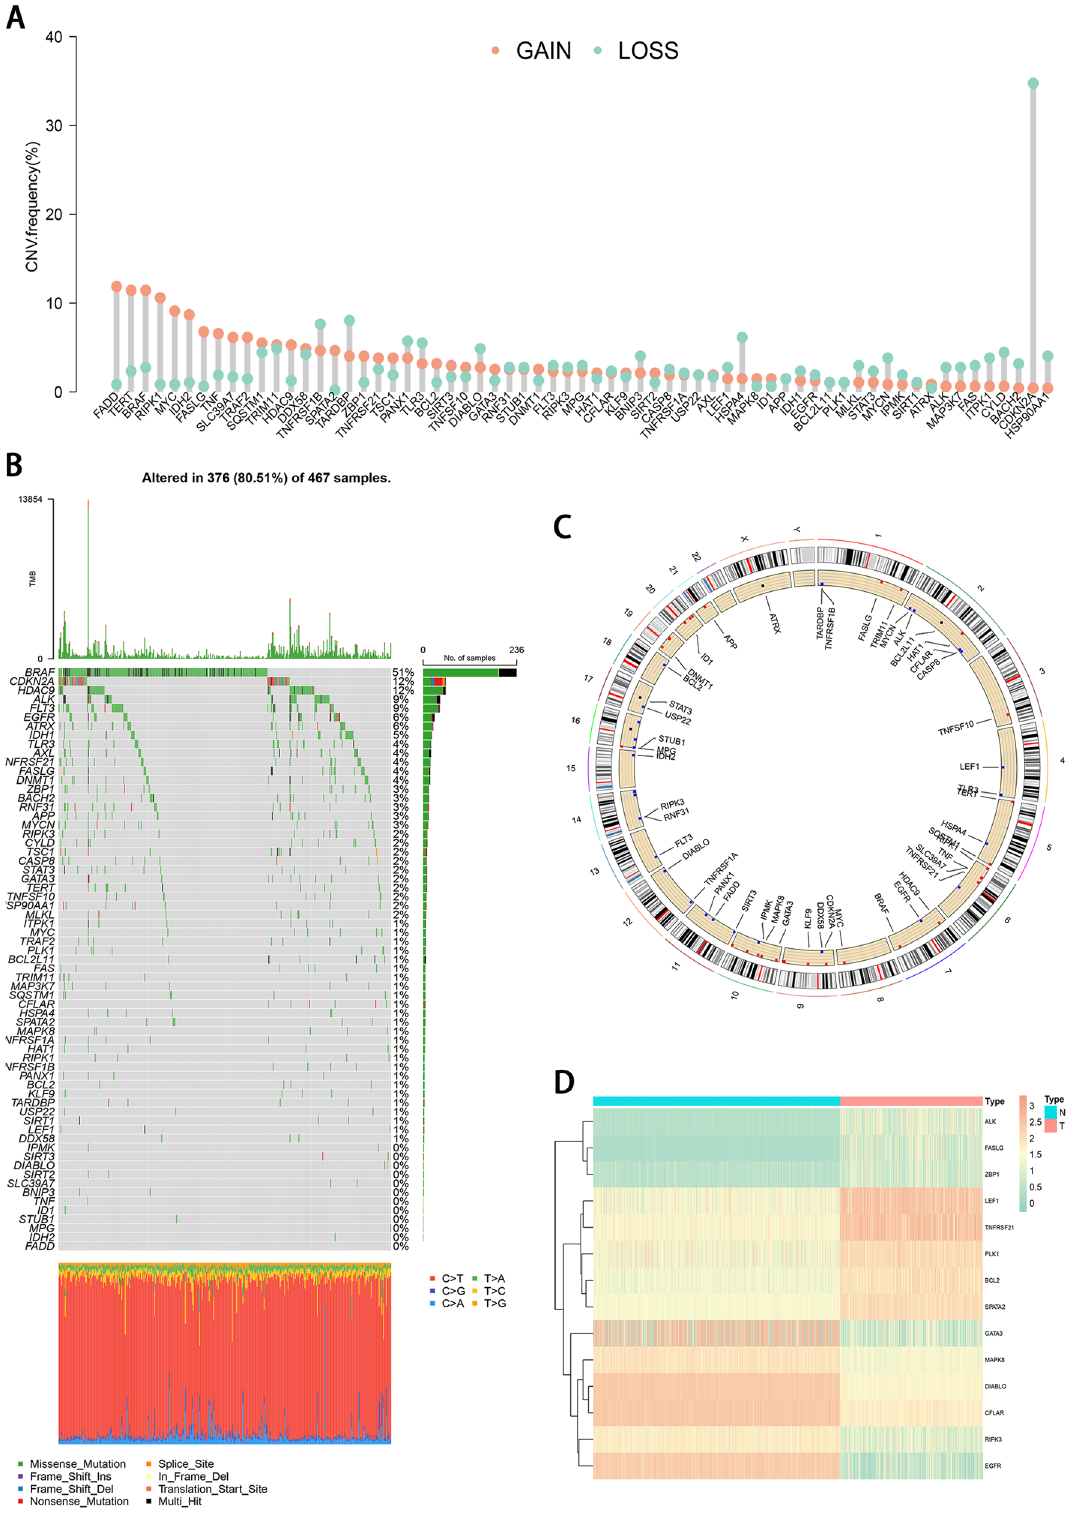
Figure 1. Landscape of genetic variation of 65 necroptosis-related genes in melanoma. ( A ) The CNV frequency of 65 necroptosis-related genes. ( B ) The somatic mutation of 65 necroptosis-related genes. ( C ) The location of the 65 necroptosis-related genes in human chromosomes. ( D ) Expression levels of 14 differentially expressed necroptosis-related genes between normal tissue and tumor